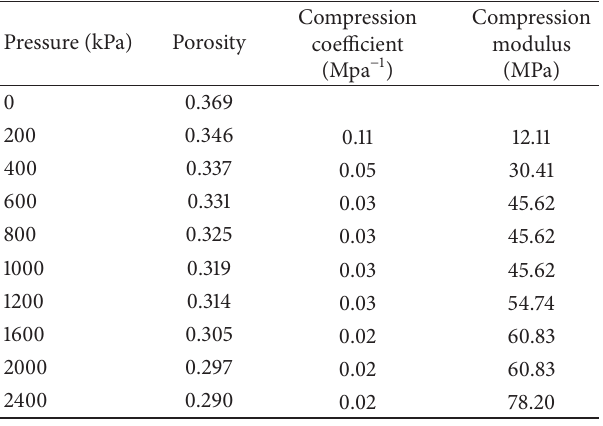
Table 2: Pressure and compression modulus.